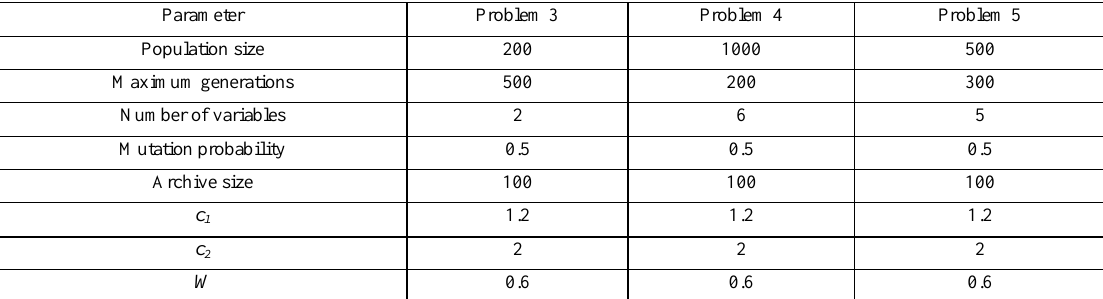
Table 2. Parameters used by MOPSO for Problem 3, Problem 4 and Problem 5